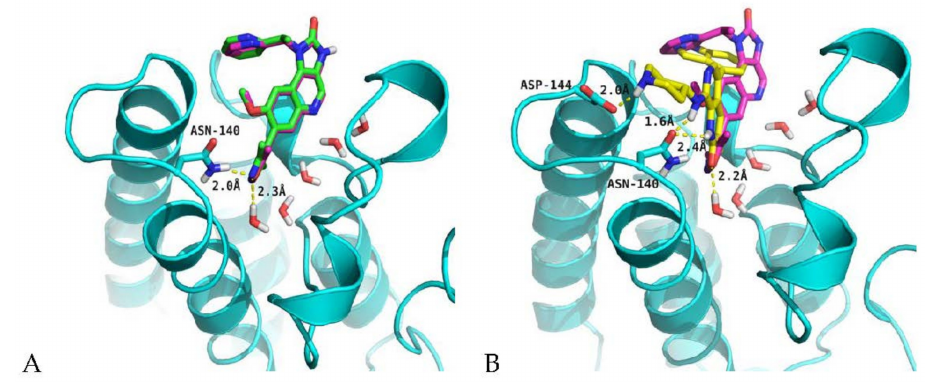
Figure 4. Docking pose of the ligands in the active site of the BRD4 protein (cyan) along with water molecules (red and white sticks). ( A ) Superposition of best pose of the co-crystal ligand (green) on the bound ligand (magenta) after redocking experiments; ( B ) Superposition of the docked pose of the most active compound (yellow) on the co-crystal ligand (magenta). The yellow dotted lines represent hydrogen